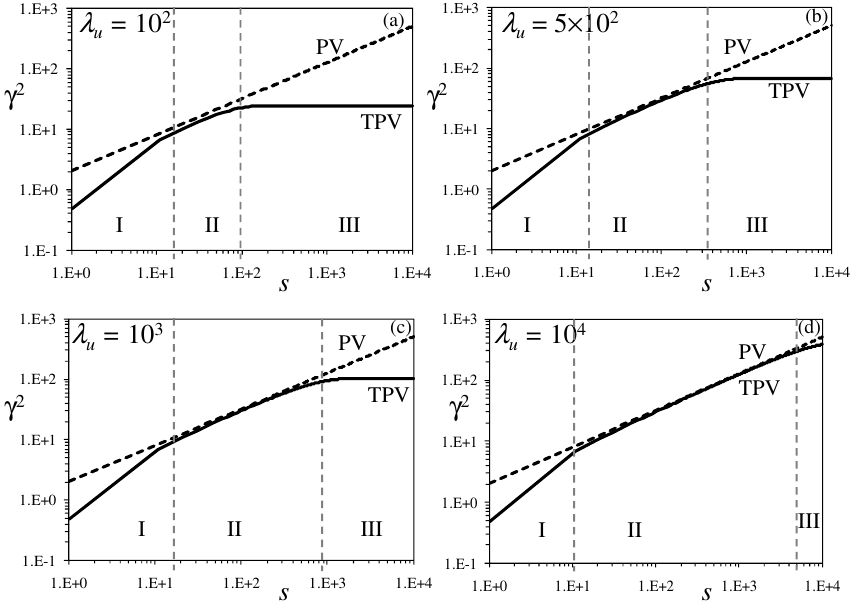
Fig. A1. Power variogram (dashed curves) and truncated power variogram (continuous curves) evaluated with A =1, H =0.3, λ l =10 and λ u = (a) 10 2 (b) 5 × 10 2 (c) 10 3 (d) 10 4 .